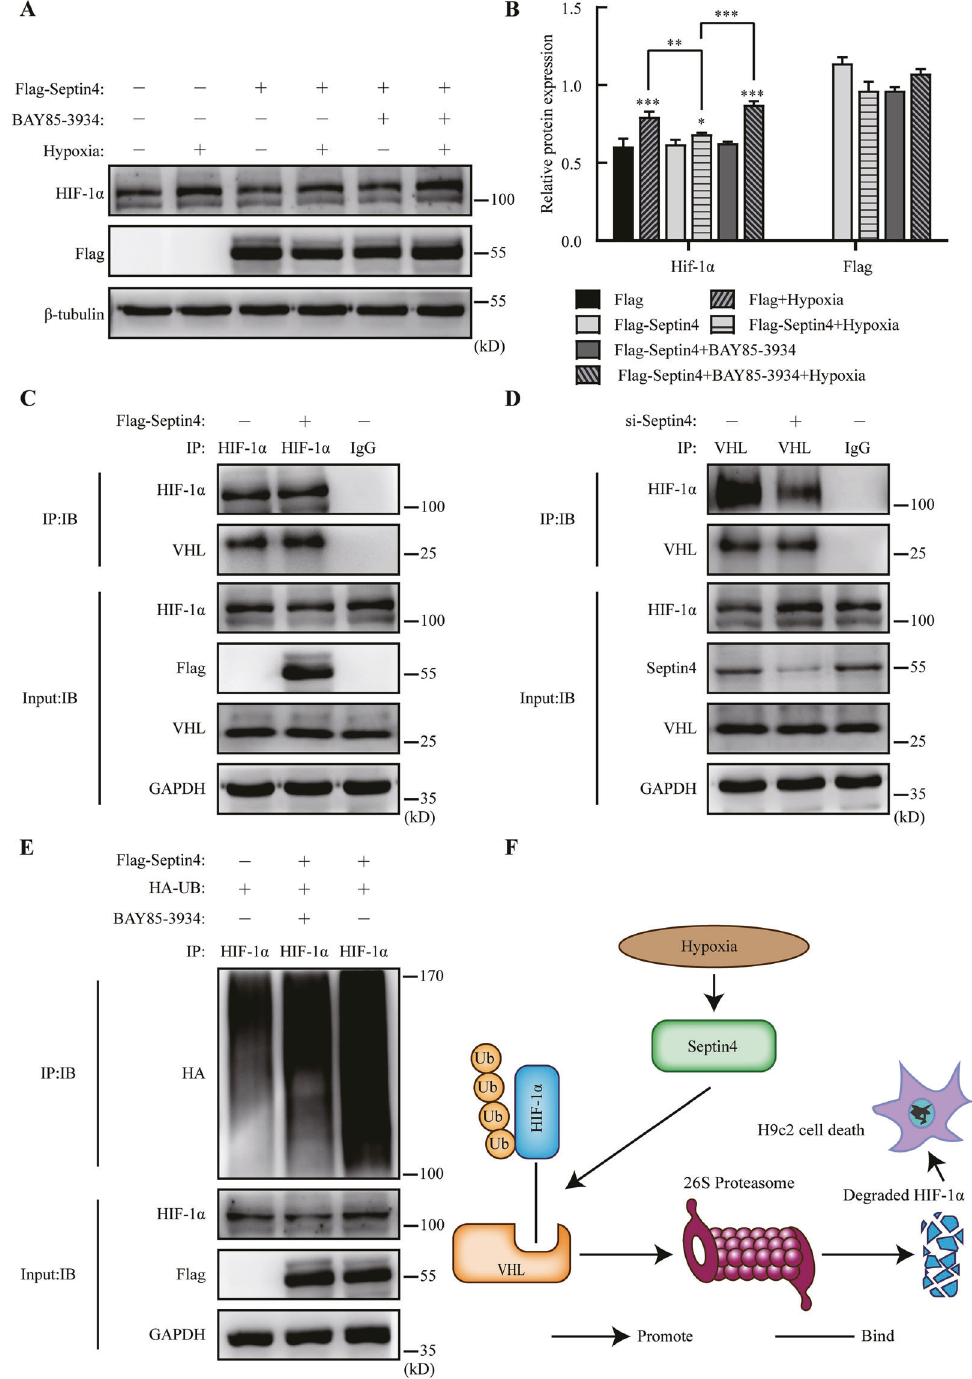
Fig. 6 Down-regulation of HIF-1 α by Septin4 through ubiquitination-proteasome pathway requires VHL. A , B Western blot analysis of the expression levels of HIF-1 α rescued by BAY85-3934 in H9c2 cells transfected with vector empty or Flag-Septin4. C Co-immunoprecipitation analysis of the role of Septin4 in regulating the endogenous interaction between VHL and HIF-1 α in H9c2 cells transfected with vector empty or Flag-Septin4. D Co-immunoprecipitation analysis of the role of Septin4 in regulating the endogenous interaction between VHL and HIF-1 α in H9c2 cells transfected with si-Con or si-Septin4. E Co-immunoprecipitation analysis of BAY85-3934 ’ s effect on the necessity of Septin4 regulating the ubiquitination levels of HIF-1 α in H9c2 cells transfected with vector empty or Flag-Septin4. F Proposed working mode of Septin4 as a negative regulator of HIF-1 α by targeting VHL-mediated HIF-1 α ubiquitin-proteasome degradation. All data are presented as mean ± SD of three repeated experiments; ***<0.001, **<0.01, *<0.05. One-way ANOVA with Tukey ’ s multiple comparisons test ( B ).